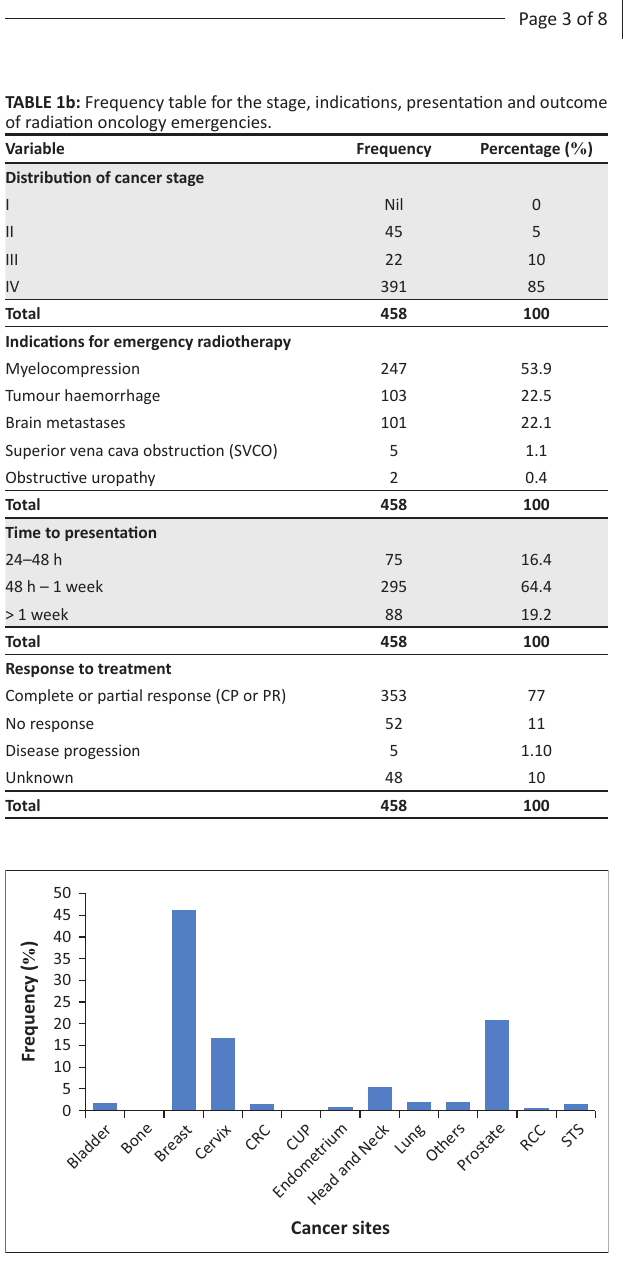
FIGURE 1: Frequency distribution of cancer sites.